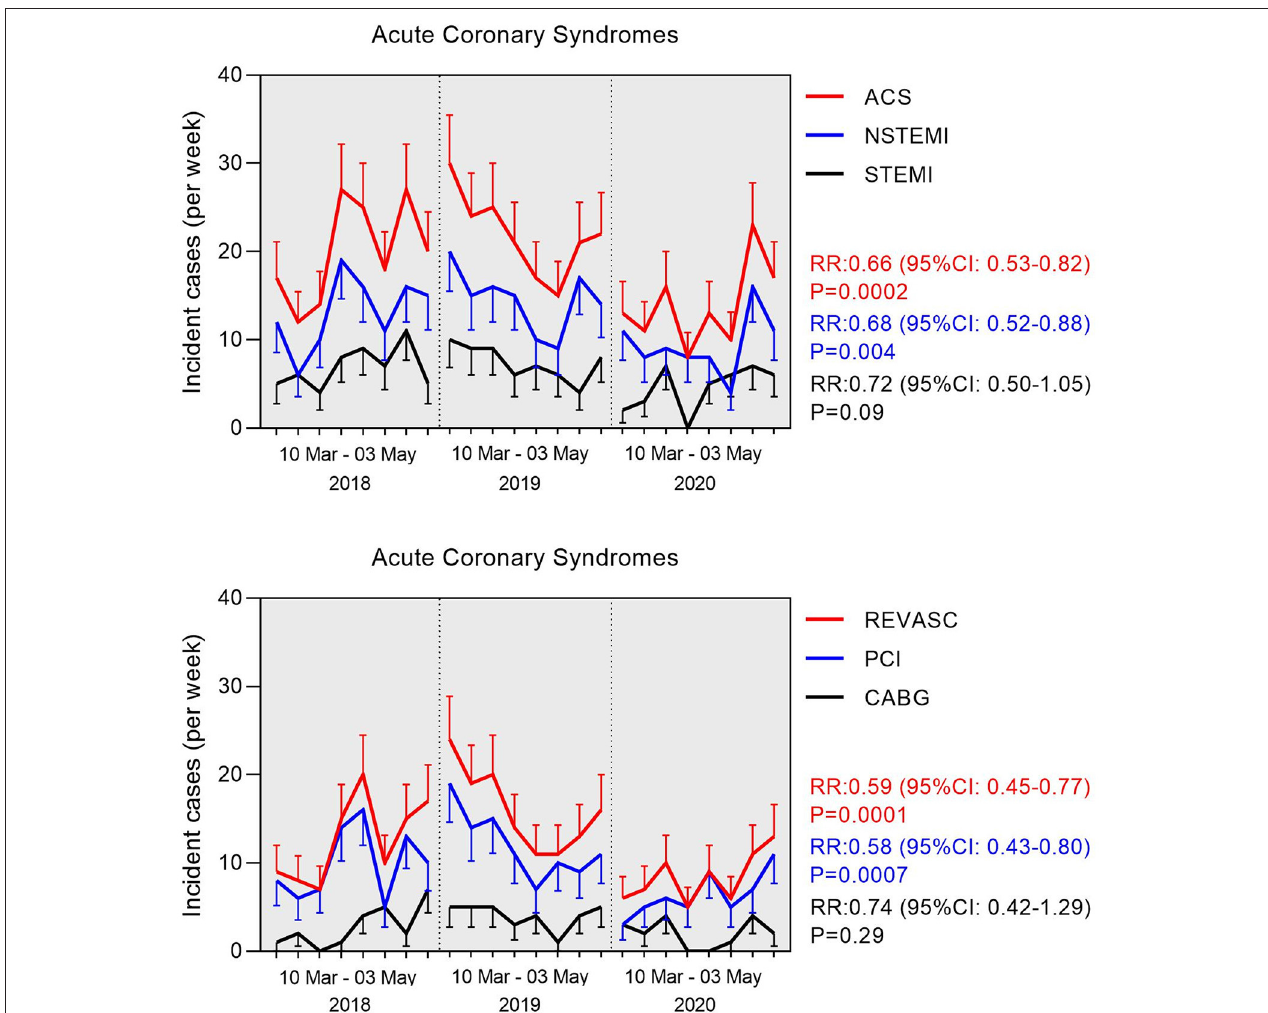
FIGURE 1 | Weekly counts of incident cases of acute coronary syndrome (ACS) between 10 March and 04 May (period of 8 weeks) during 2018, 2019, and 2020. (Top) Overall ACS incidence stratified by type of ACS (STEMI vs. NSTEMI). (Bottom) Total counts of ACS cases that underwent revascularization (REVASC) stratified by mode (PCI vs. CABG). Relative risks (RR) were calculated by Poisson regression adjusting for Covid-19